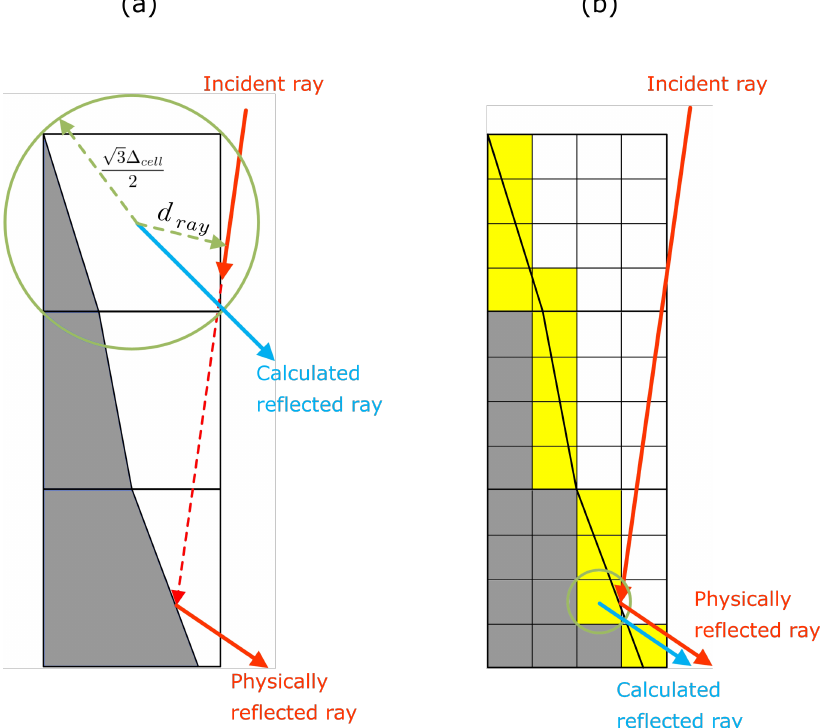
Figure 2. Schematic of the sub-ray path using a projection of the 3D cells. ( a ) The standard ray tracing method; ( b ) the ray tracing with virtual mesh refinement